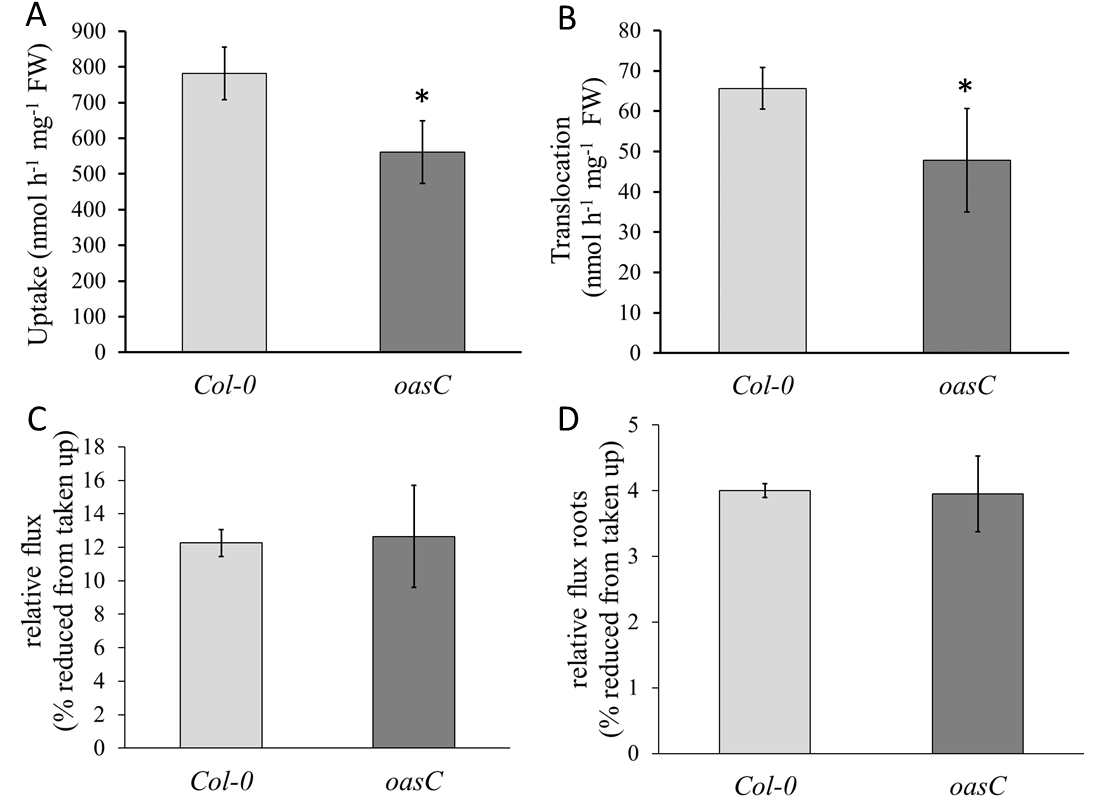
Figure 2. Sulfate uptake and translocation decreased in oasC mutant. Col-0 (light grey) and oasC (dark grey) seedlings grown on MS-agarose plates for 2.5 weeks were fed with the solution containing 35 SO 42 − for 4 h. ( A ) Sulfate uptake and ( B ) translocation to shoots was determined by scintillation counting. Relative flux was measured as incorporation of [ 35 S] in ( C ) thiols and proteins and ( D ) from the [ 35 S] sulfate taken up. Data are presented as means ± S.D. from four biological replicates. Asterisks mark values significantly different from the wild-type Col-0 at p < 0.05 (Student’s t -test).